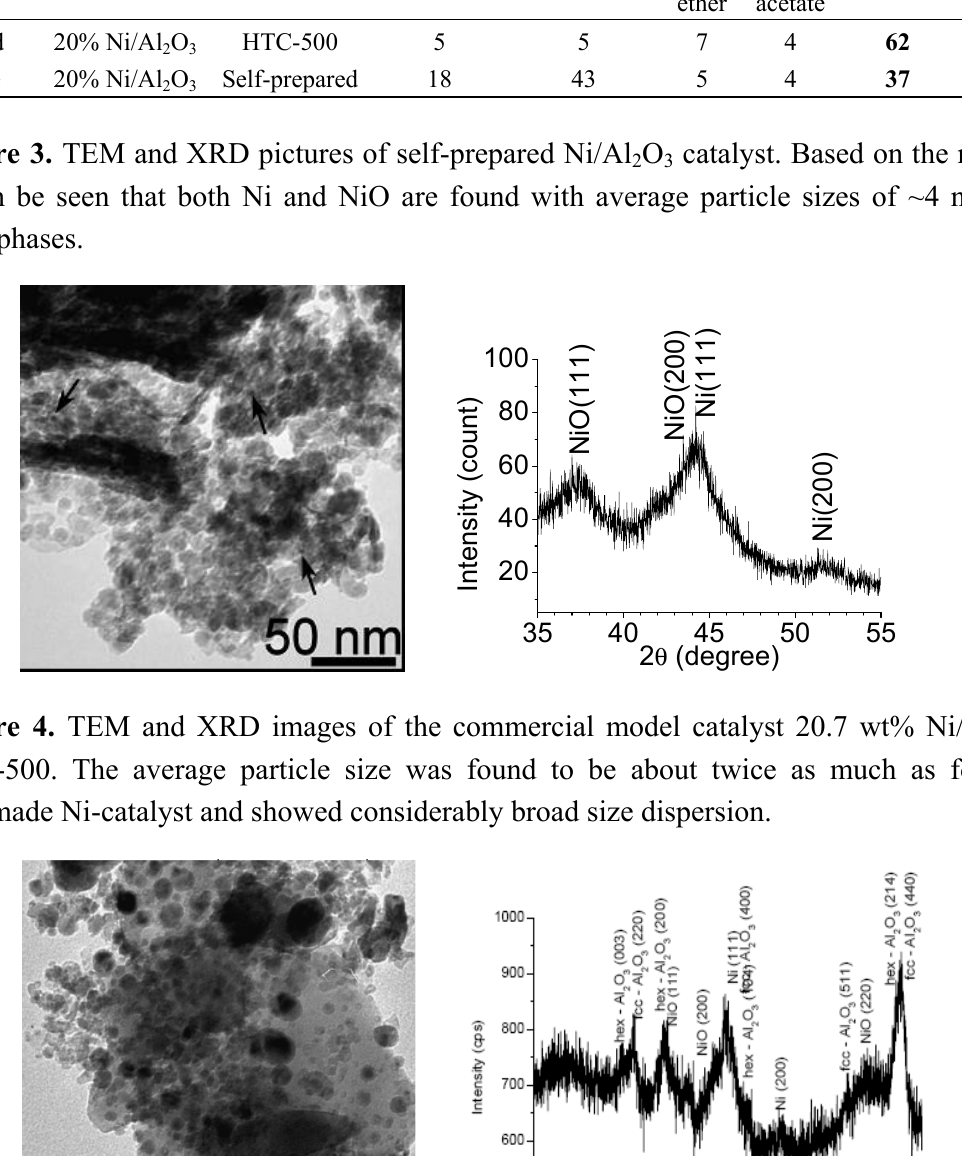
Table 8. Results obtained with alumina supported Ni catalysts.